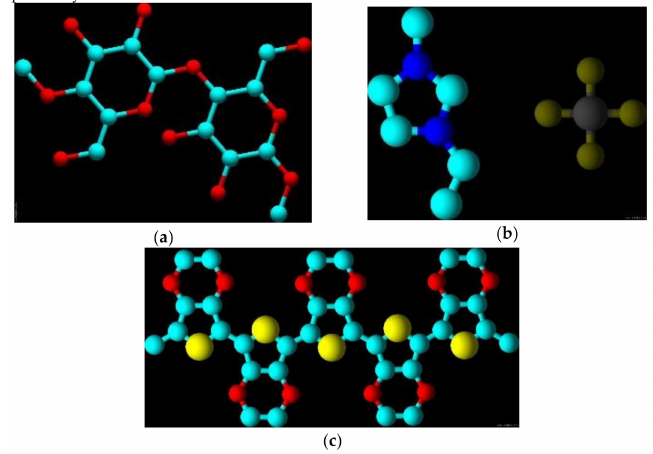
Figure 1. 3D chemical structure of BC ( a ), EMIM-BF 4 ( b ), and PEDOT ( c ).